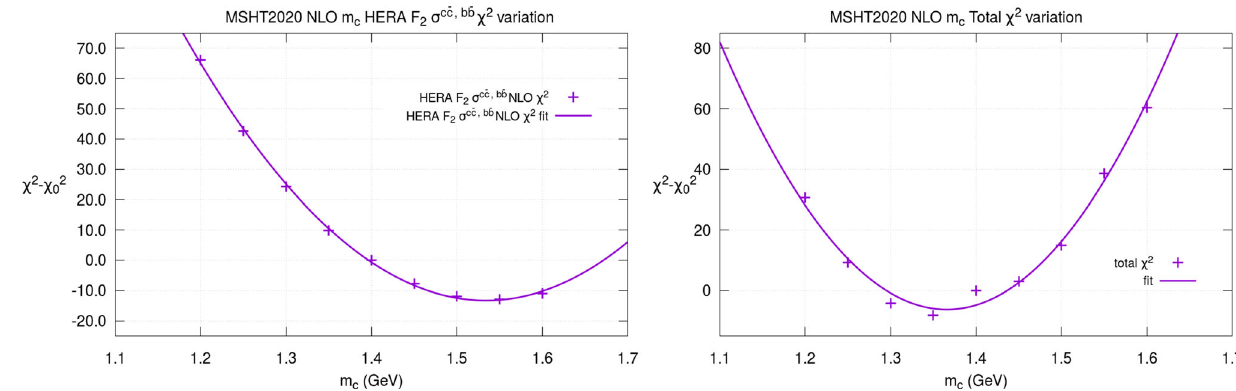
) = 0 . 118 for (left)the reduced cross sectionfor charm and bottom production Z